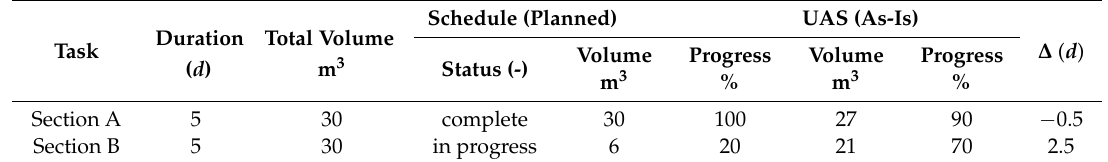
Table 1. Schedule difference calculation.